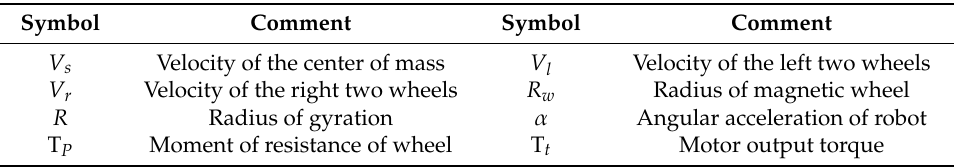
Table 4. Parameters in the mechanical model.